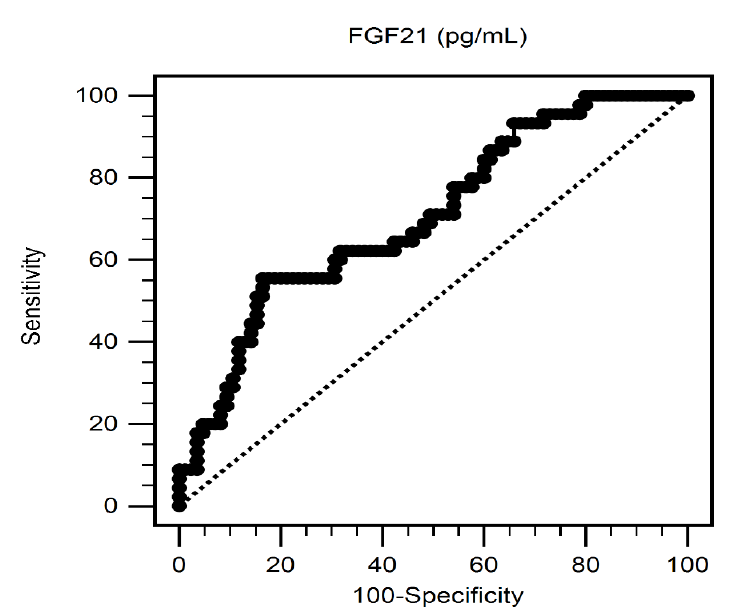
Figure 1. Receiver operating characteristic curve analysis of FGF-21 to predict aortic stiffness of T2DM patients. The area under the curve indicated the predictive power of FGF-21 for aortic stiffness of T2DM patients.